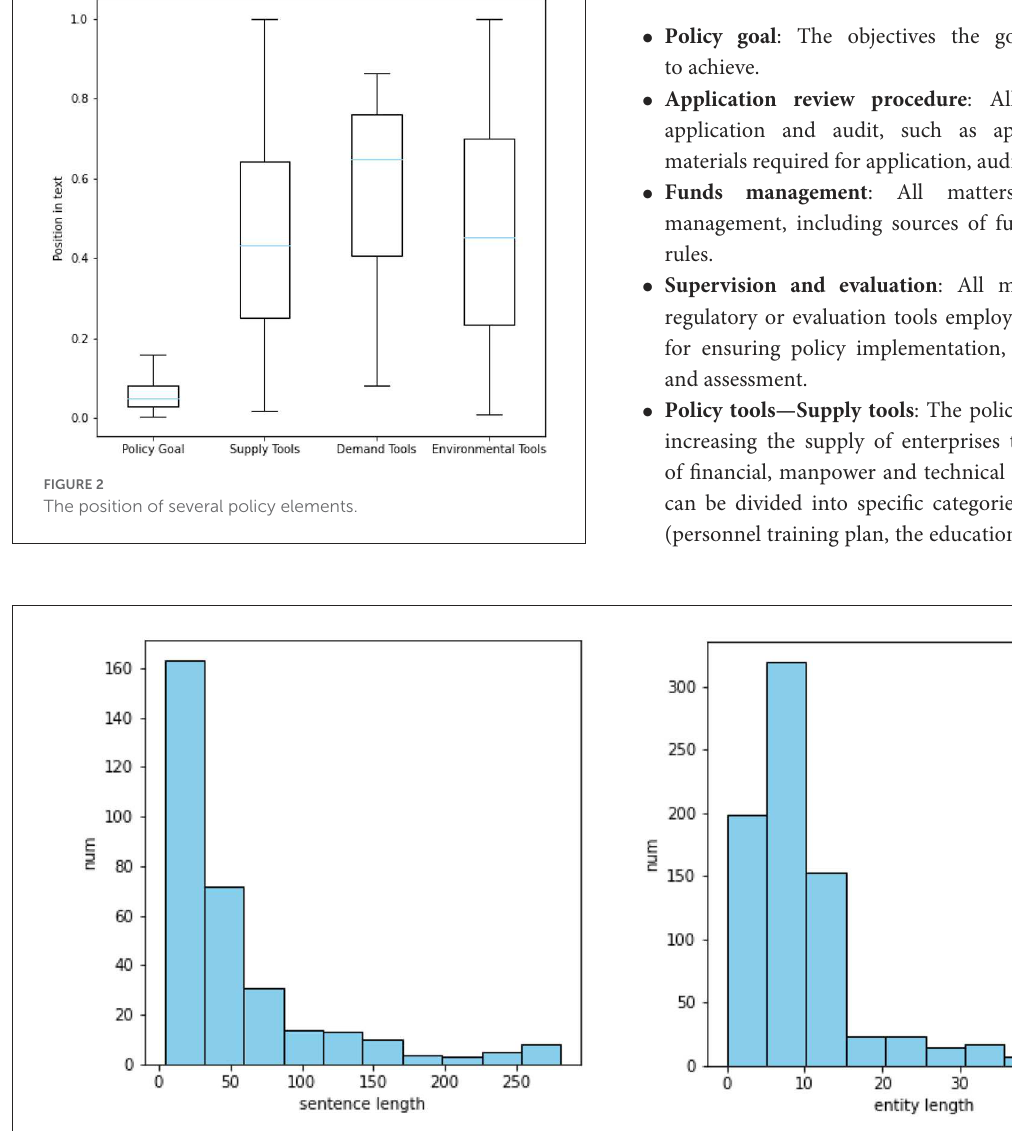
FIGURE3 Length distribution of sentences containing policy entities and length distribution of policy entities in 81